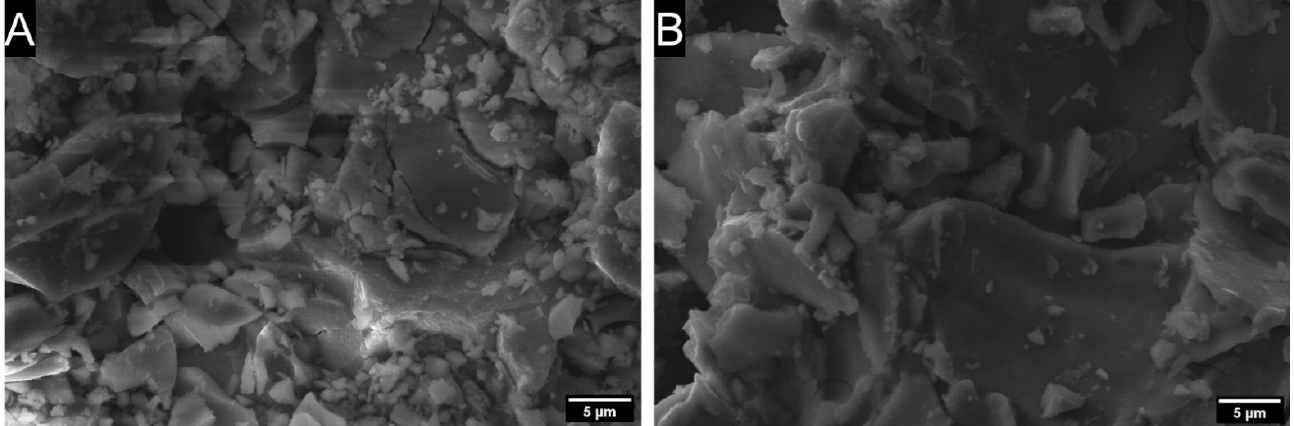
Figure 2. SEM images of immobilised ( A ) TiO 2 and ( B ) rGO/TiO 2 on surface of glass substrate be- fore use.